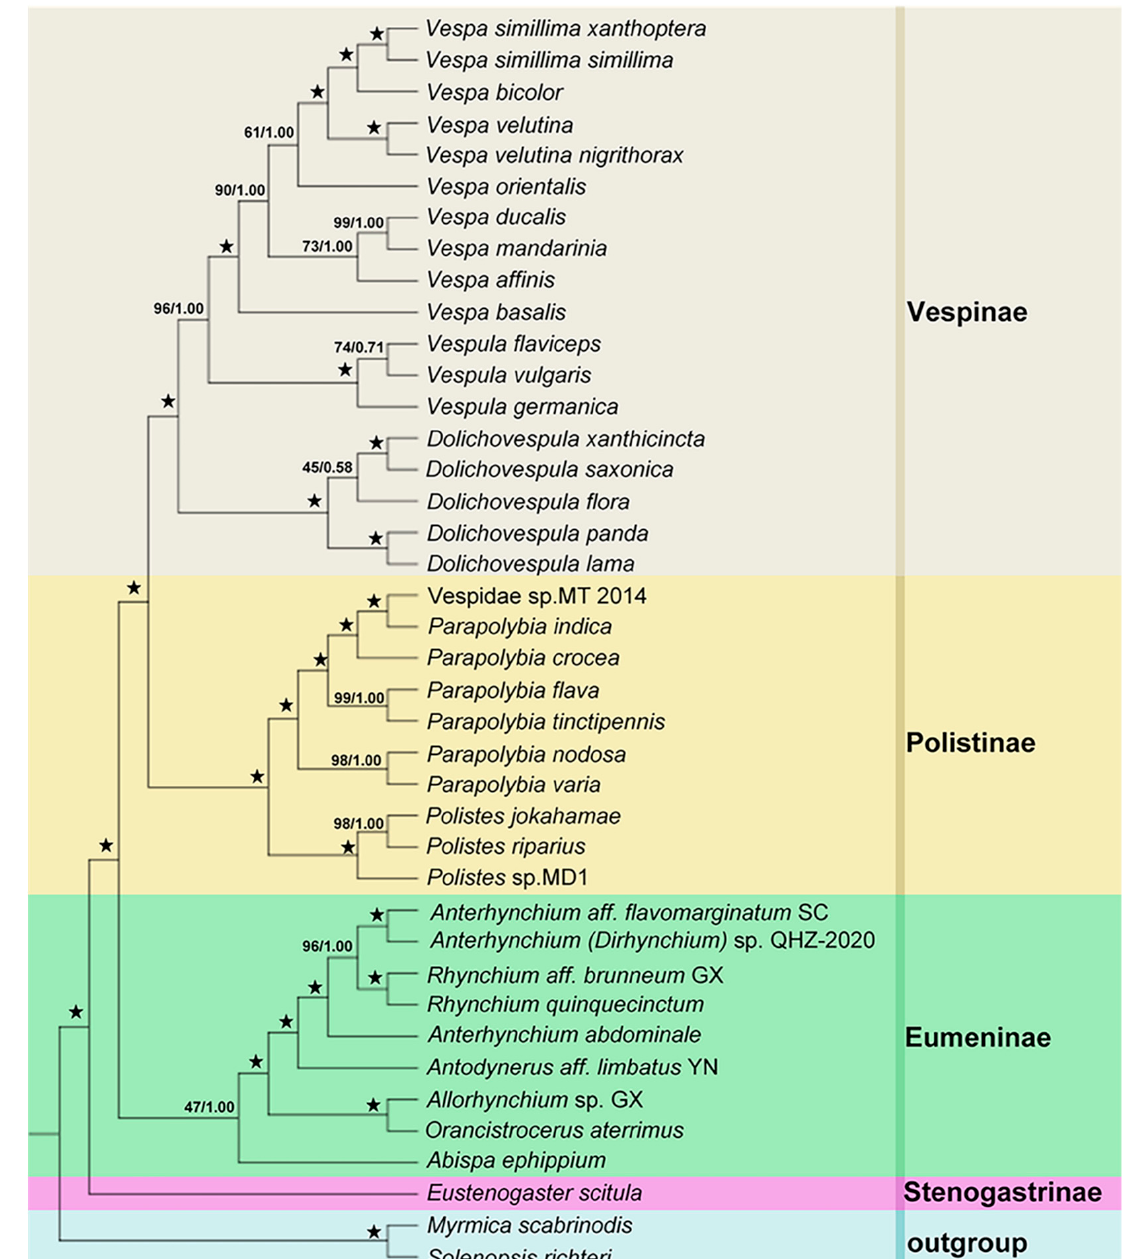
Figure 4. Phylogenetic tree of Vespidae based on the PCG123 dataset by BI and ML methods. Values above the nodes represent Bayesian posterior probabilities/ML bootstrap values. “ ★ ” indicates Bayesian posterior probabilities = 1.00 and ML bootstrap = 100.